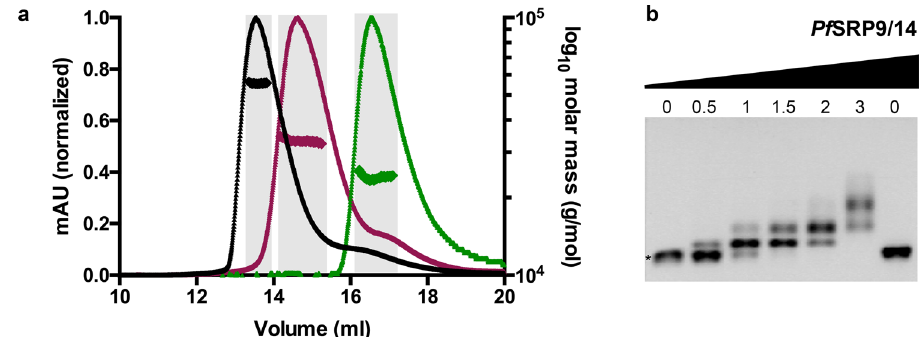
Fig. 2 Assembly of the Pf Alu domain. a Pro fi les of size-exclusion chromatography coupled to multi-angle light scattering of Pf Alu118 RNA (magenta), Pf SRP9/14 (green), and the complete Pf Alu domain comprising Pf Alu118 RNA and Pf SRP9/14 (black) are shown. Molar mass distribution across the respective peaks is marked and fractions used for obtaining an average molar mass are highlighted in gray. b EMSA showing quantitative shifts of the Pf Alu118 RNA upon titration with increasing amounts of Pf SRP9/14. The asterisk (*) indicates unbound RNA. The molar-fold excess of Pf SRP9/14 over Pf Alu118 RNA is indicated on the top. The uncropped gel image is included in Supplementary